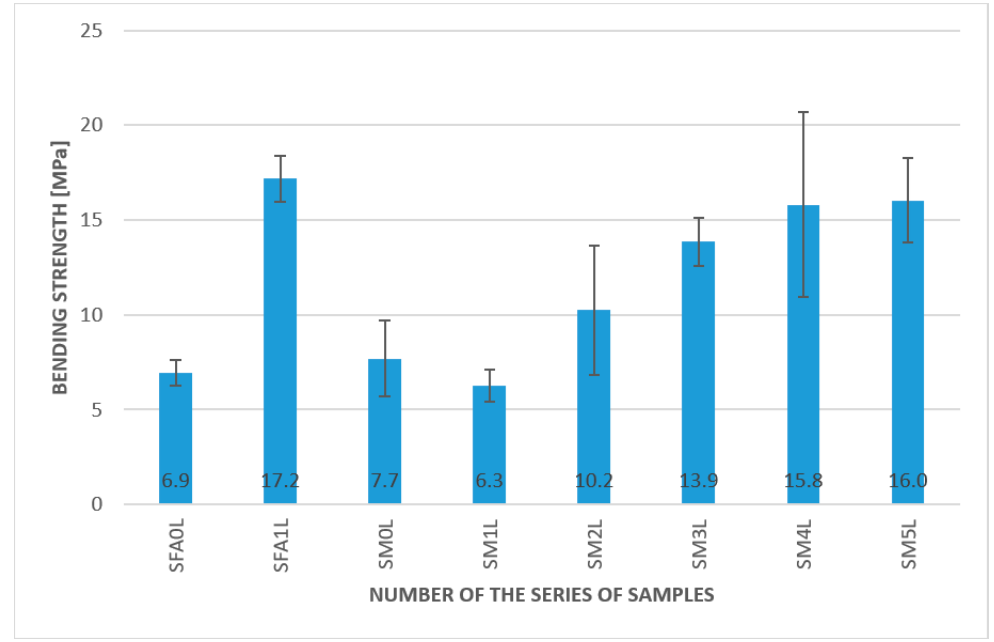
Figure 10. Results of the bending strength test for geopolymer composites with a lowered temper- ature.